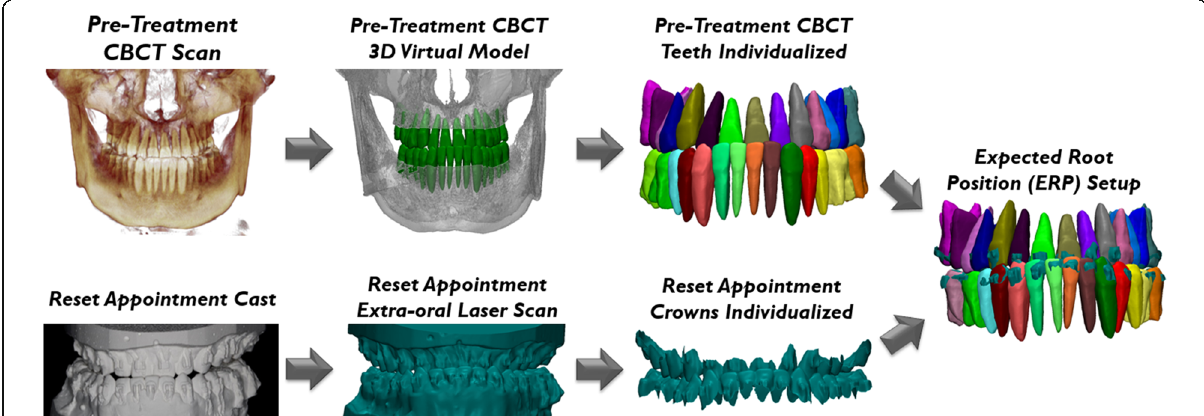
Fig. 2 Generation of the ERP setup. The teeth from the pre-treatment CBCT scan are segmented and isolated. The reset appointment cast is scanned with an extra-oral laser scanner and individualized. The pre-treatment CBCT teeth are superimposed onto the reset appointment crowns yielding the ERP